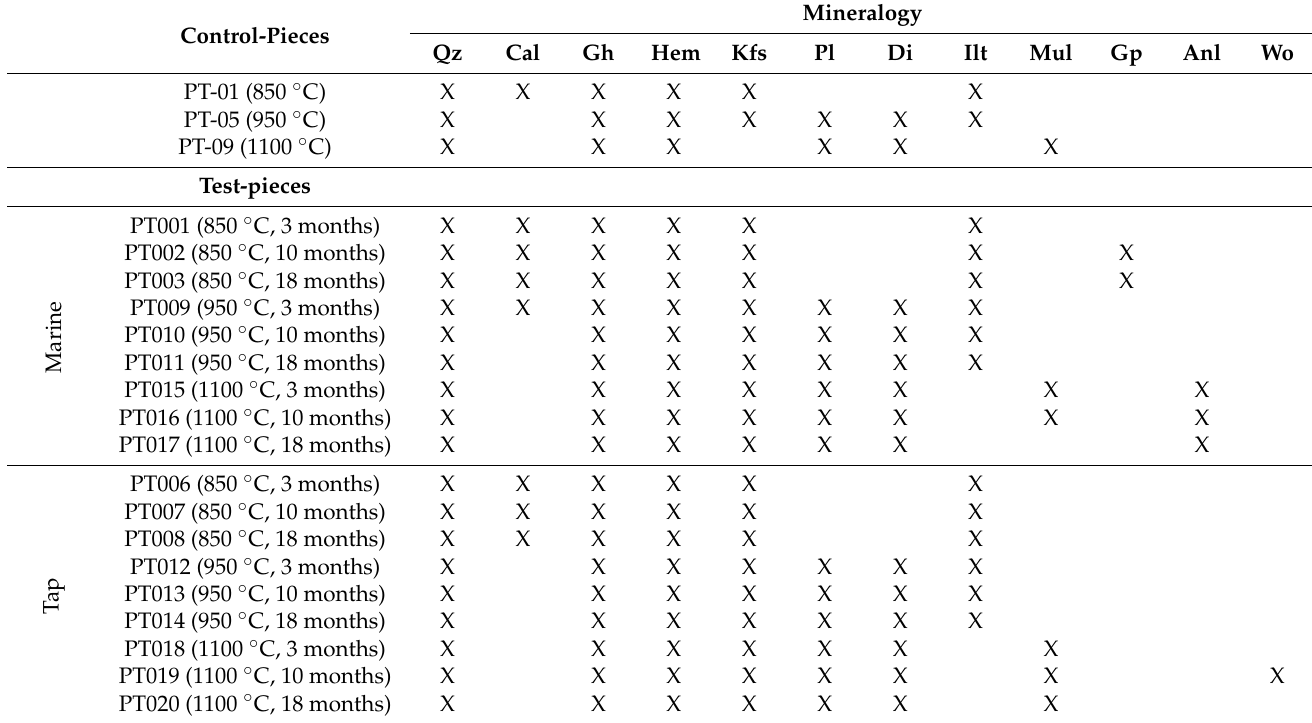
Table 5. Summary of the mineralogical phases of the control, marine and tap PT pieces. Qz = quartz; Cal = calcite; Gh = gehlenite; Hem = hematite; Kfs = potassium feldspar; Pl = plagioclase; Di = diopside; Ilt = illite; Gp = gypsum; Anl = analcime; Mul = mullite; Wo = wollastonite, abbreviations according to Whitney and Evans (2010)